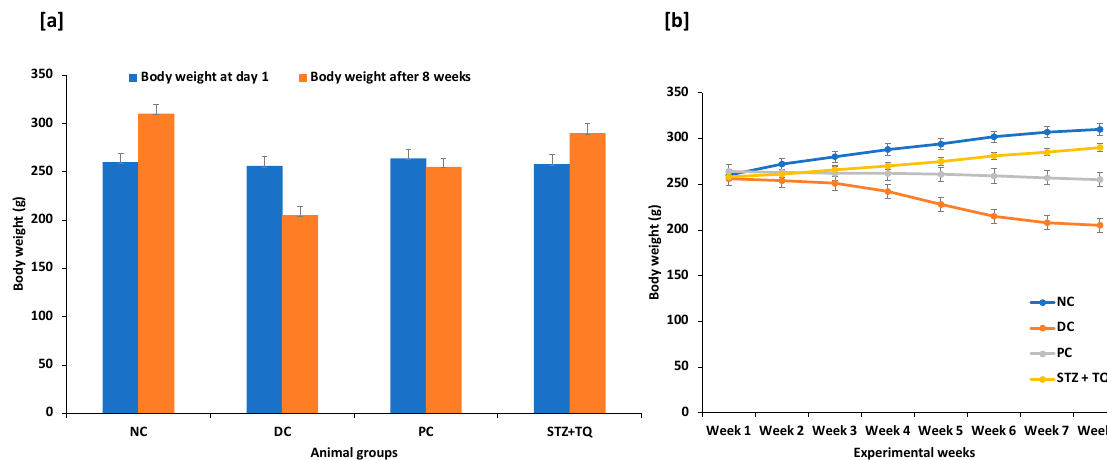
Figure 1. ( a ) The initial and the last body weight of different groups of rats after 8 weeks of experiment. ( b ) The week-wise measurement of body weight of all experimental animals from week 1 to week 8. The animals were randomly distributed into each group ( n = 8 per group). Data are means ± standard error of the mean (SEM). Groups: Normal control (NC); disease control (DC) i.e., STZ-treated group; positive control (PC) animal treated with STZ and Glibenclamide; diabetic rats treated with TQ (STZ + TQ). p < 0.05 (significant difference of final b.w. between DC vs. NC) p < 0.05 (significant difference of final b.w. between DC vs. STZ + TQ).